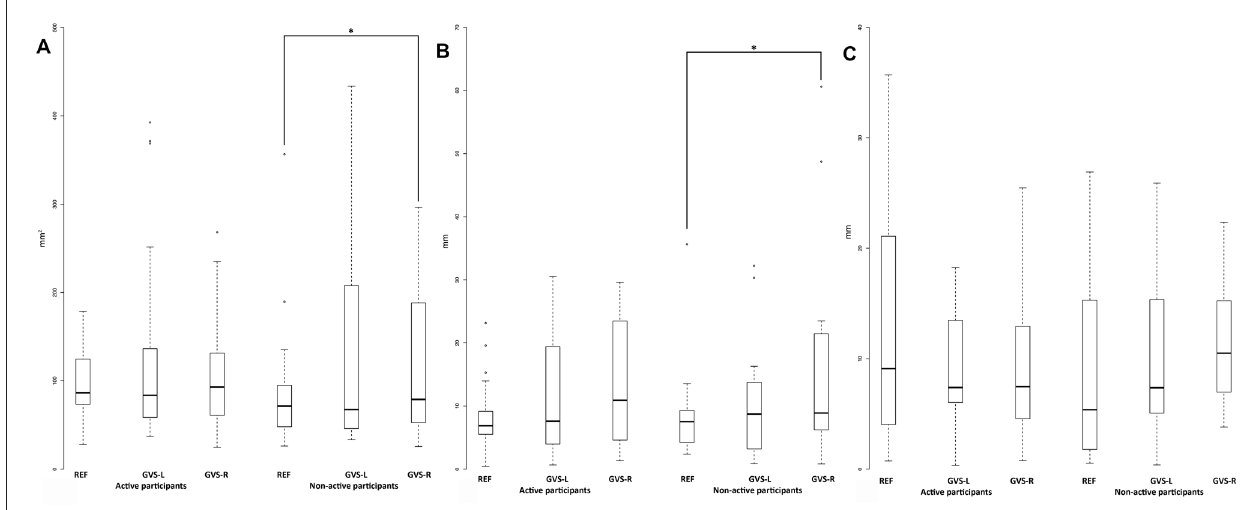
FIGURE 2 | The COP surface (A) , the COP X amplitude (B) and the COP Y amplitude (C) in the reference and the GVS conditions for the active and non-active groups. ∗ Indicates p < 0.05.